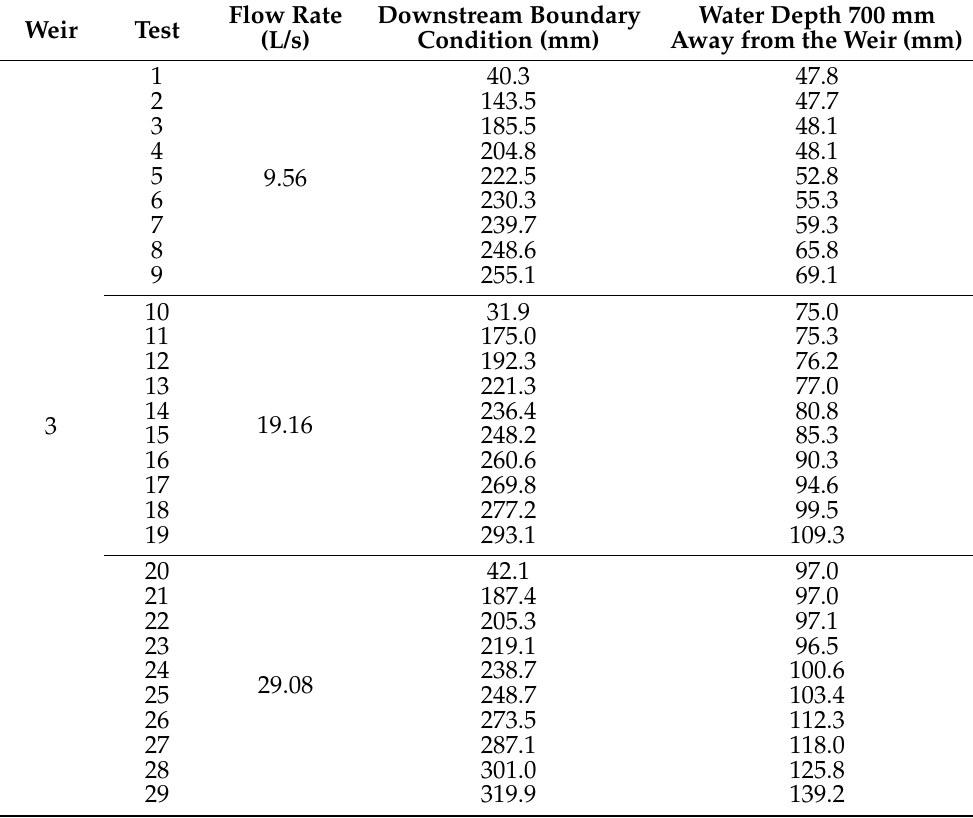
Table A2. Experimental data corresponding to the second experimental